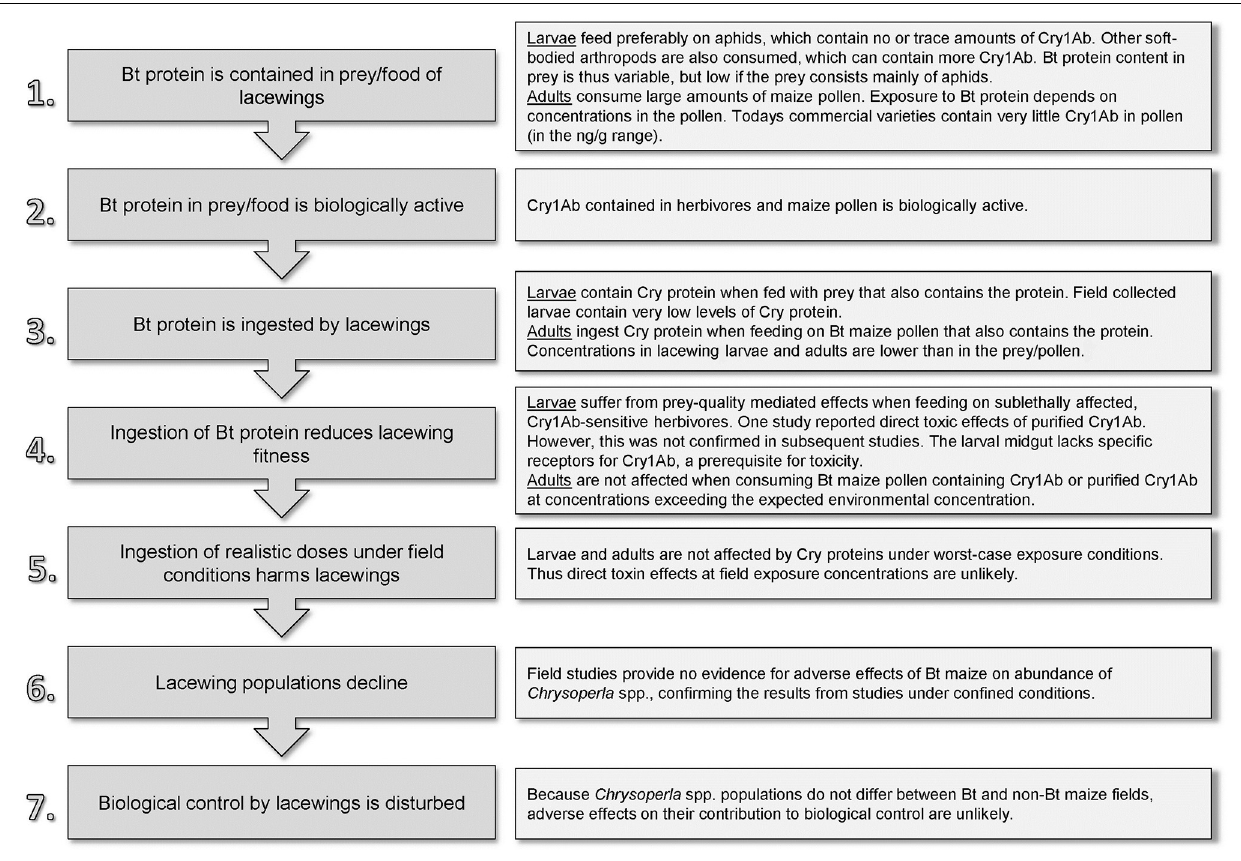
FIGURE 2 | The pathway of how Bt (Cry1Ab) maize might directly harm Chrysoperla carnea and a summary of published